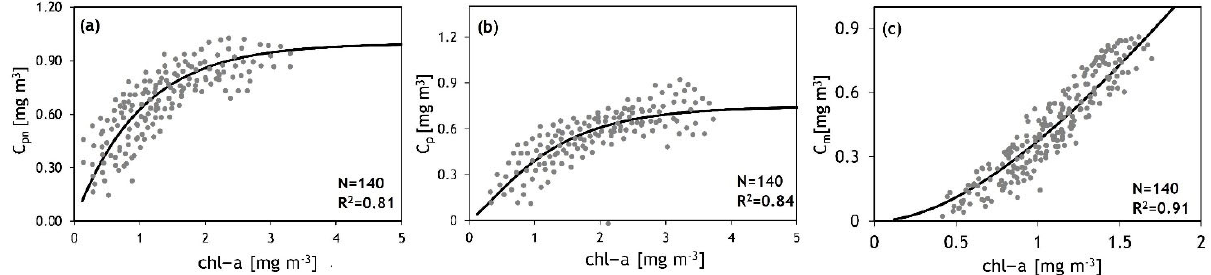
Figure 2. The in − situ size − specific chl − a plotted against the in situ chl − a [grey points]. ( a ) Pico + Nano plankton relation to total chl − a , ( b ) Picoplankton relation to total chl − a, and ( c ) microplankton in relation to total chl − a . The model fit is represented in a solid line.